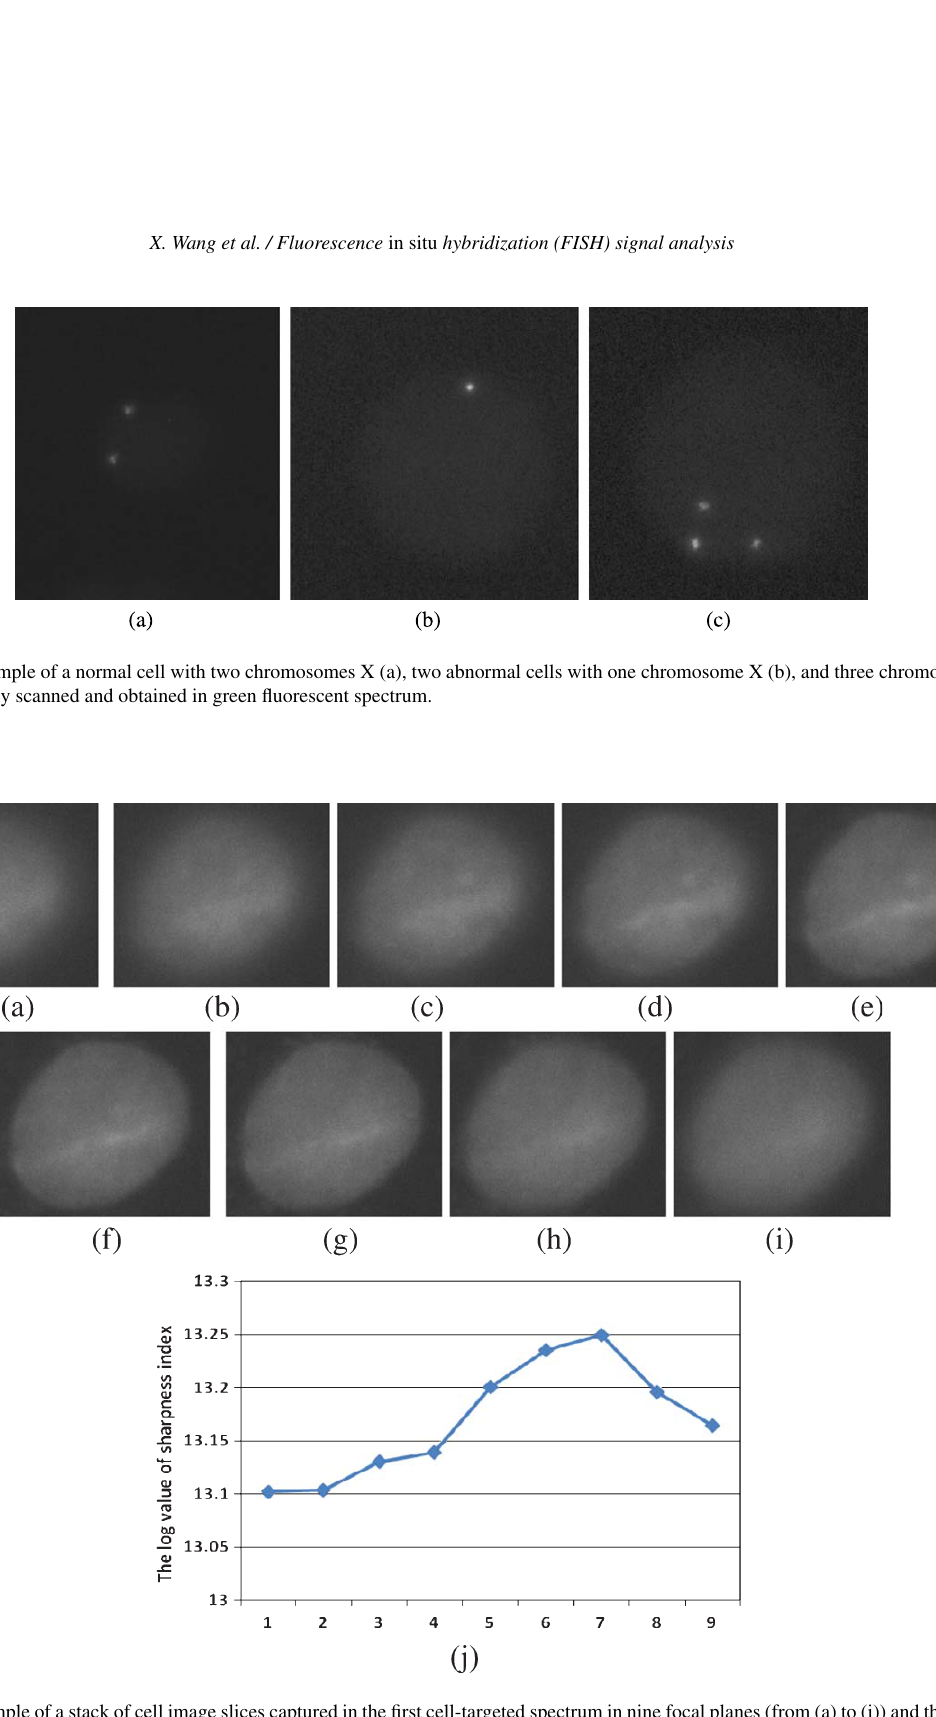
Fig. 3. An example of a stack of cell image slices captured in the first cell-targeted spectrum in nine focal planes (from (a) to (i)) and the change of the computed sharpness indices from these nine cell image